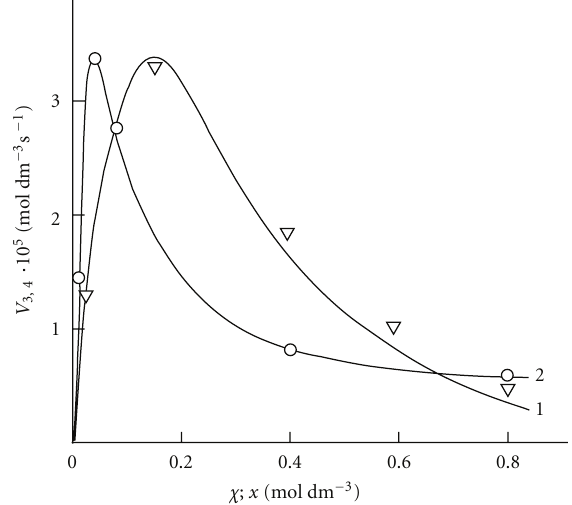
Figure 1: Reconstruction of the functional dependences (curves) of the product formation rates V 3, 4 (1) on the initial mole fraction of the unsaturated component ( χ ) from empirical data (symbols) using (3c) (model optimization with respect to the parameter α ) for the phosphorus trichloride-methylpropene reaction system at 303 K [19] (standard deviation of S Y = 2 . 58 × 10 − 6 ) and (2) on the initial concentration of the unsaturated component ( x ) from empirical data (symbols) using (4b) (model optimization with respect to V 1 , x m , and α ) for the 2-propanol-2-propen-1-ol s system at 433K [23] ( S Y = 5 . 91 × 10 − 7